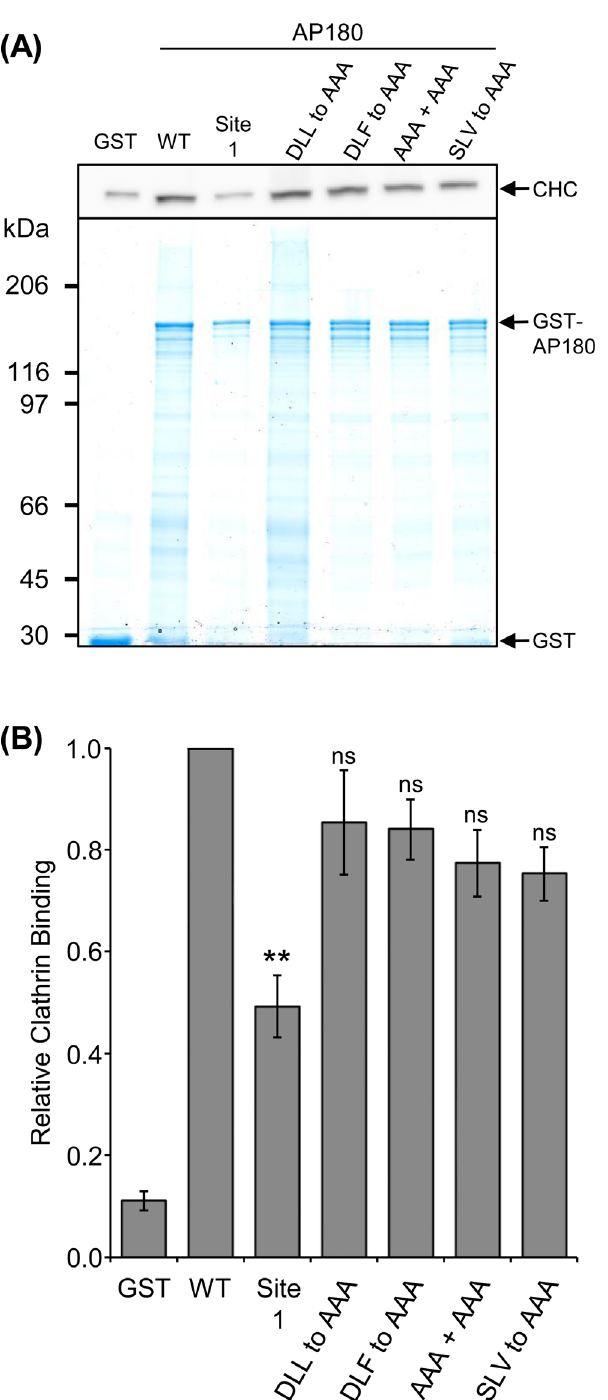
Fig 6. Extraction of clathrin from synaptosome lysate by GST-tagged AP180 WT, Site 1 and CBM mutants. (A) AP180 WT and the following mutant sequences, Site 1, 666-DLL-668 to AAA, 638-DLF-640 to AAA, both 666-DLL-668 and 638-DLF-640 to AAA (AAA+AAA) and 756-SLV-758 to AAA, were used in 1 h pull-downs with rat synaptosome lysate and the amount of clathrin bound was determined by Western blot with anti-clathrin heavy chain (CHC) using 25% of the sample. Five percent of the sample was resolved by SDS-PAGE and stained with Coomassie for comparison of bait levels. Representative Western blot and SDS-PAGE gel is shown from three 1 h pull-down experiments. (B) Comparison of clathrin binding from the densitometry of each 1 h pull-down with the AP180 mutants normalised to AP180 WT. Data is expressed